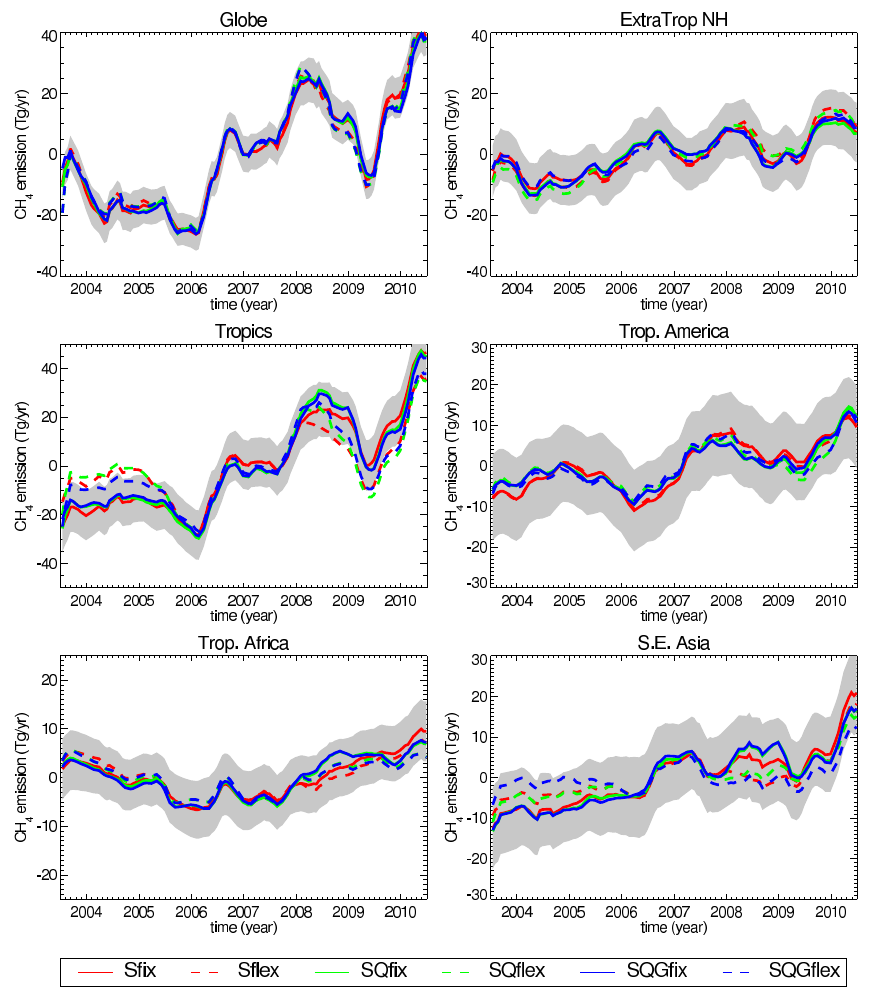
Fig. 12. As Fig. 11, with means subtracted. Fig. 12. As Figure 11, with means subtracted. with results from B13. Integrated over the globe, the av- erage of the posterior emissions of our inversions amount to 527 ± 4 TgCH 4 yr − 1 , in close agreement with B13. Note that, despite the significant differences in inter-annual varia- tion between the inversions, the 8-year integrated fluxes span only a small range. The Northern Hemisphere accounts for 78 % of global emissions, without a significant shift